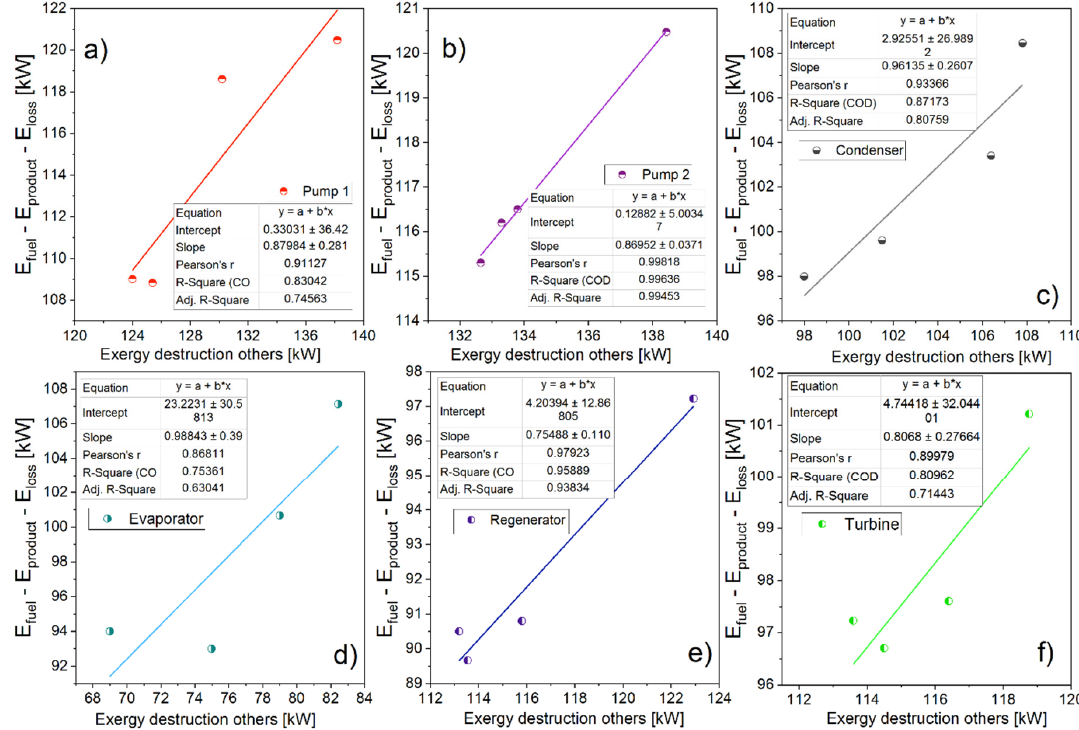
Figure 4. Endogenous destruction of exergy of acetone ( a ) Pump 1, ( b ) Pump 2, ( c ) condenser, ( d ) evaporator, ( e ) regenerator, and ( f ) turbine.